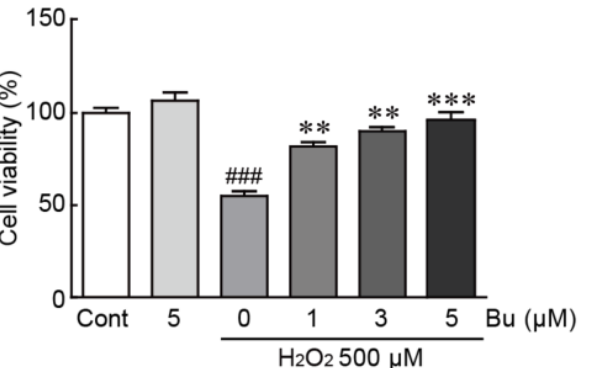
Figure 2. Butein increases the cell viability of H 2 O 2 -treated H9c2 cardiomyoblasts. The cell viability was determined by MTT assay after treating with butein and/or H 2 O 2 . The results are shown as the mean ± SEM in triplicate. ### p < 0.001 vs. control group. ** p < 0.01 and *** p < 0.001 vs. H 2 O 2 -alone group. Cont; control, Bu; butein.